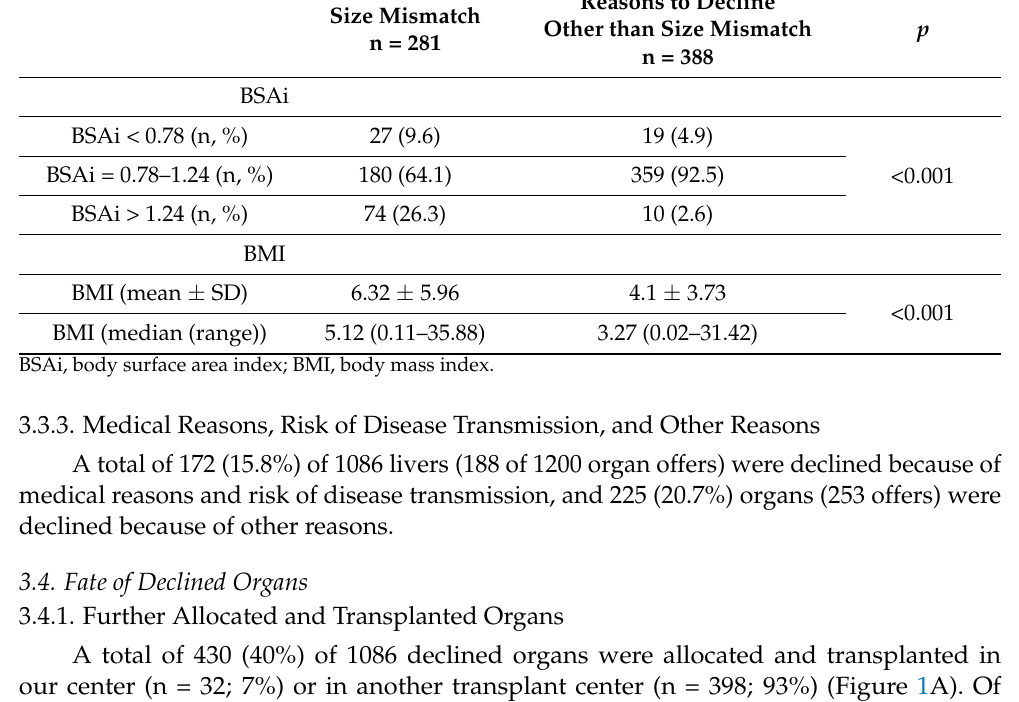
Table 3. BSAi analysis and comparison between organ offers declined because of size (BMI) mismatch and offers declined because of reasons other than size mismatch. Reasons to Decline Size Mismatch Other than Size Mismatch n = 281 n =